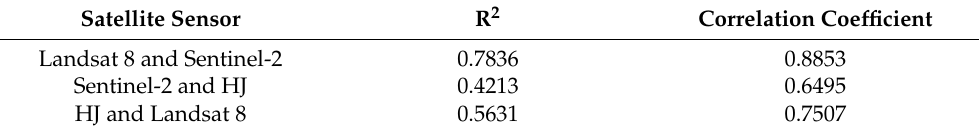
Figure 8. Correlation analysis of NDVI value based on random points (The figures include the con- version equation and correlation coefficient between every pair of sensors for NDVI. ( a ) shows the fitting result of NDVI between Landsat 8 and Sentinel-2; ( b ) shows the fitting result of NDVI be- tween Sentinel-2 and HJ; ( c ) shows the fitting result of NDVI between HJ and Sentinel-2). Table 5. The NDVI fitting results of the West Expansion Dump under multi-source sensor monitoring. Satellite Sensor